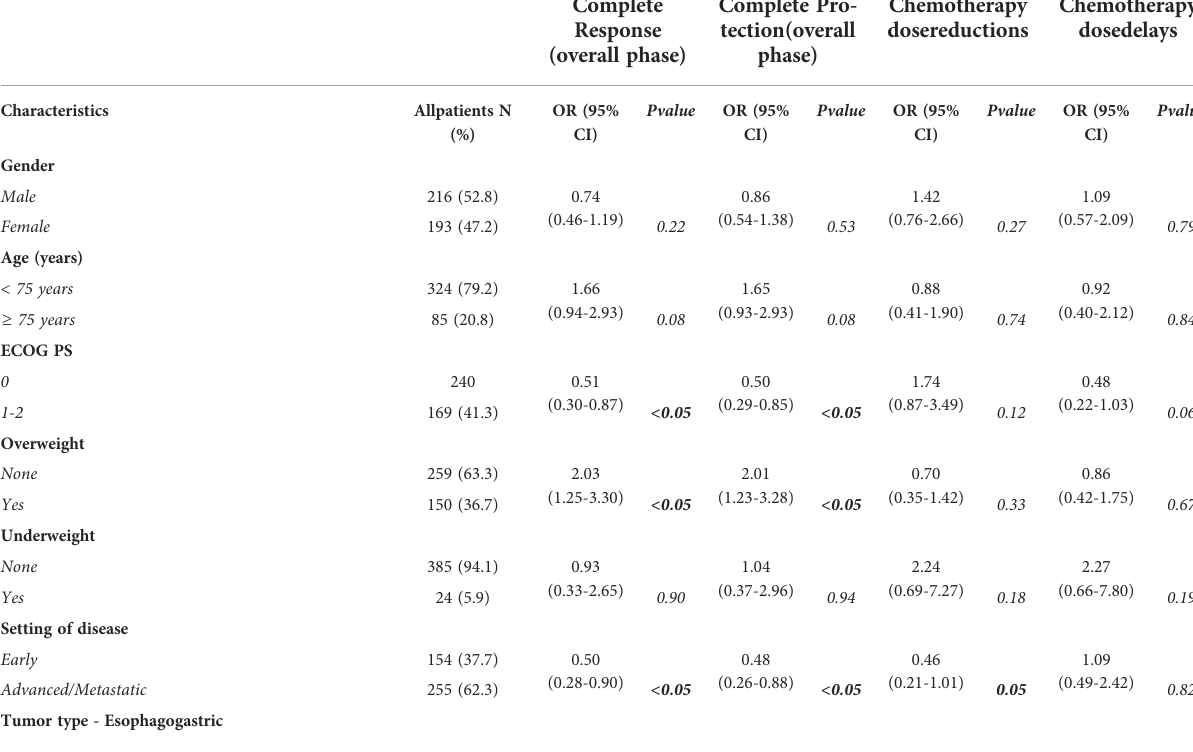
TABLE 2B Multivariate analysis for the effectiveness outcome